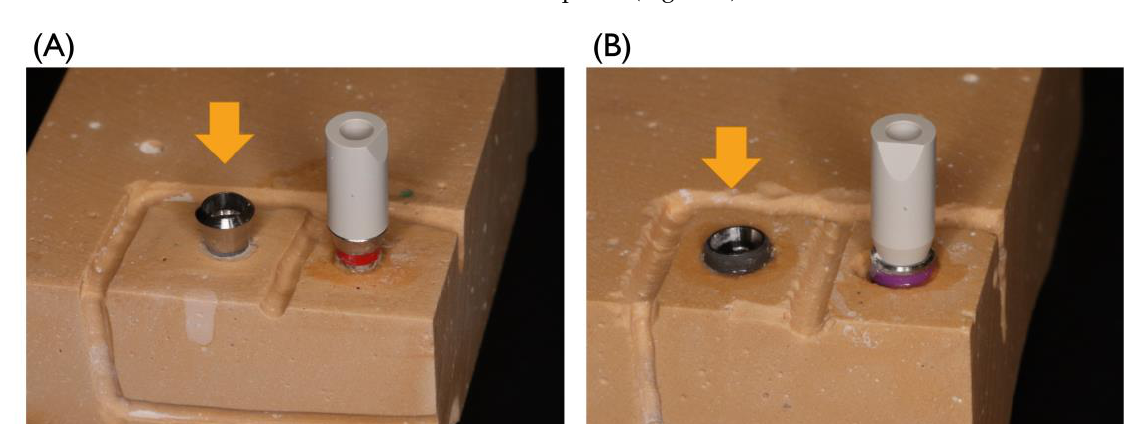
Figure 1. An implant analog for TL ( A ) or BL ( B ) on the right and an implant body for TL on the left were placed in improved dental stone, and the SB was tightened onto the implant analog on the right as a reference. Then, an SB was tightened on the left implant body (arrows) with a standardized torque (15 Ncm) and the distance and angle between two scan bodies were measured.